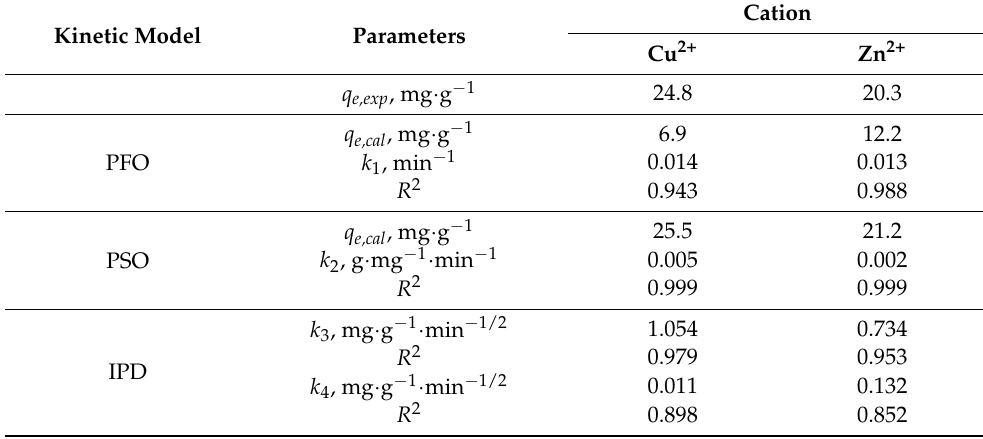
Table 8. The kinetic parameters of Cu 2+ and Zn 2+ adsorption process onto the SSB6 biochar.